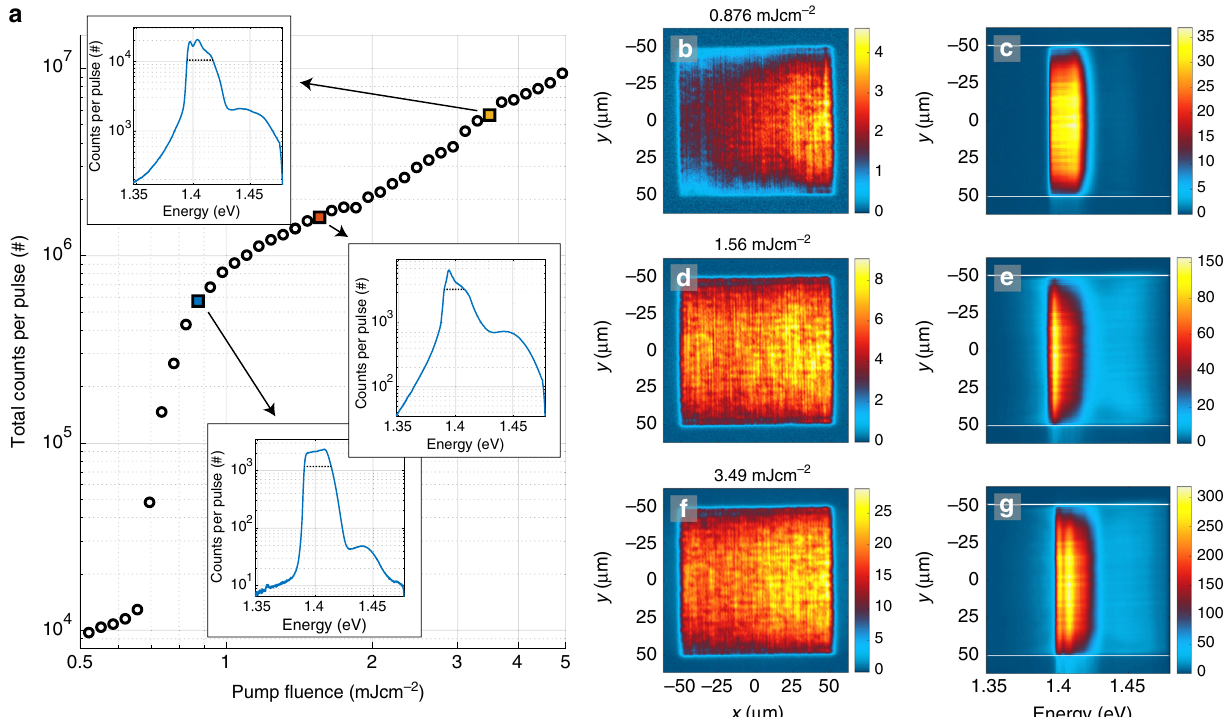
Fig. 6 Pump fl uence dependence, real space images and spectra for 500 fs pump pulse duration. a Pump fl uence dependence of the total luminescence intensity. Insets: Line spectra obtained by integrating over the real space spectra in the y -direction (between the white lines). b – g Left column: Real space images of the plasmonic lattice. Right column: Spectral information of the luminescence as a function of position in the y -axis. The pump fl uence is b , c 0.88 mJ cm − 2 , d , e 1.6 mJ cm − 2 , f , g 3.5 mJ cm − 2 . FWHM of the spectral peaks is marked in the insets. With increasing pump fl uence, we obtain a FWHM of 23, 18, and 23 meV. The results for the full range of pump fl uences are presented in Supplementary Movie 3.